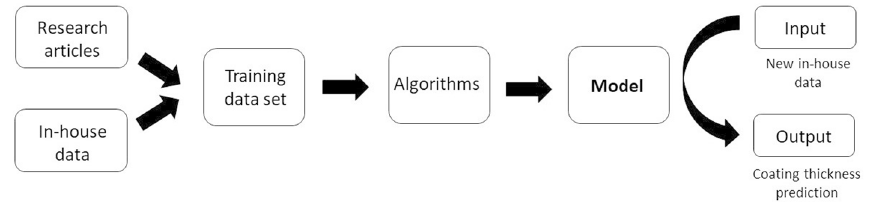
Figure 1. Workflow for coating thickness prediction using supervised machine learning